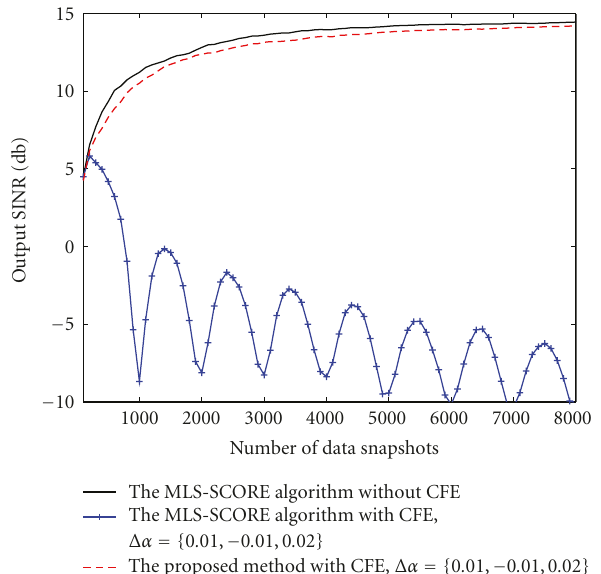
Figure 2: Output SINR versus number of data snapshots for Example 2